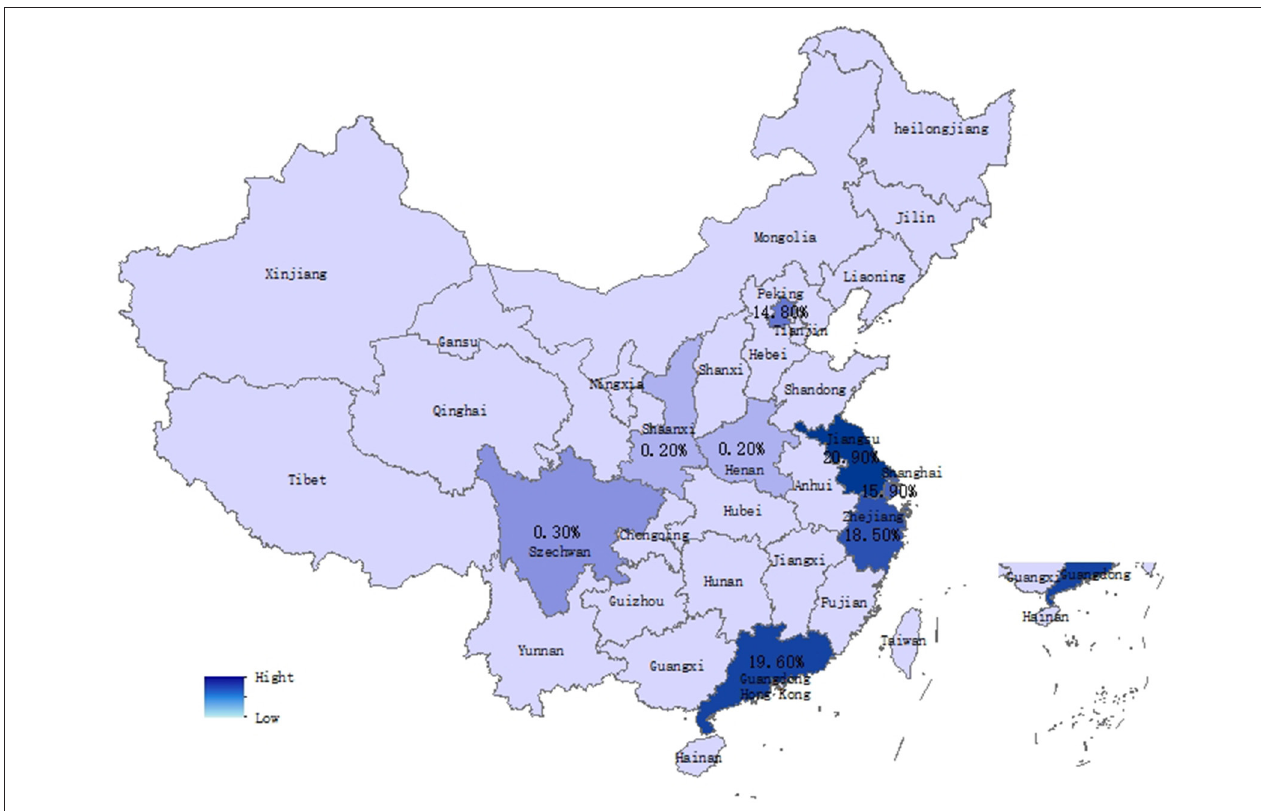
FIGURE 2 | Regional distribution of netizens involved in Changchun Longevity Biotechnology Co., Ltd., vaccine fraud incident (www.zhiweidata.com). The nine provinces marked with numerical values are the most active netizens in this public opinion event, and the numerical values represent their proportion in the top